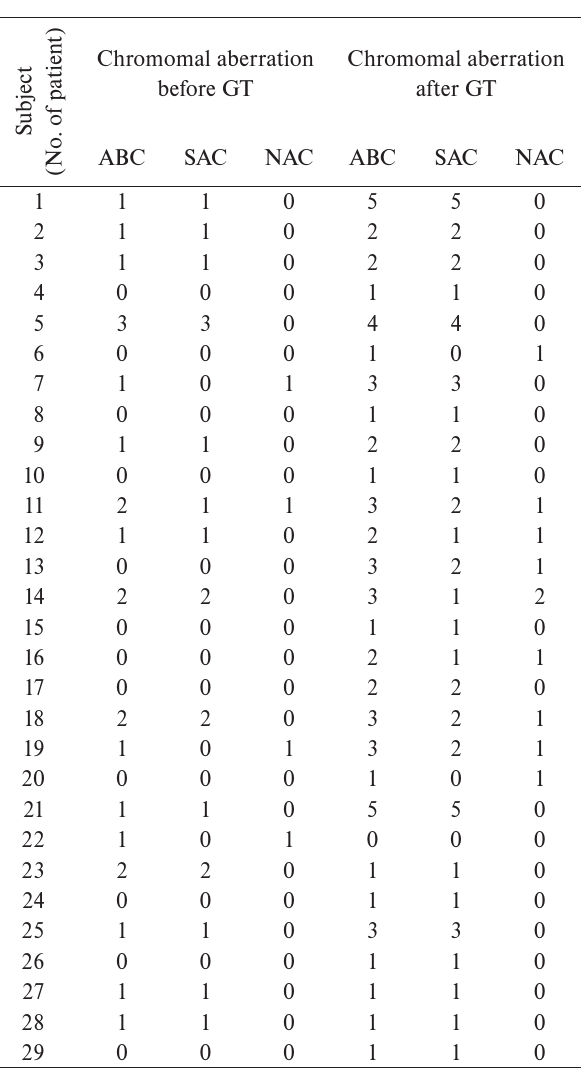
Table 1. Chromosomal aberrations in peripheral